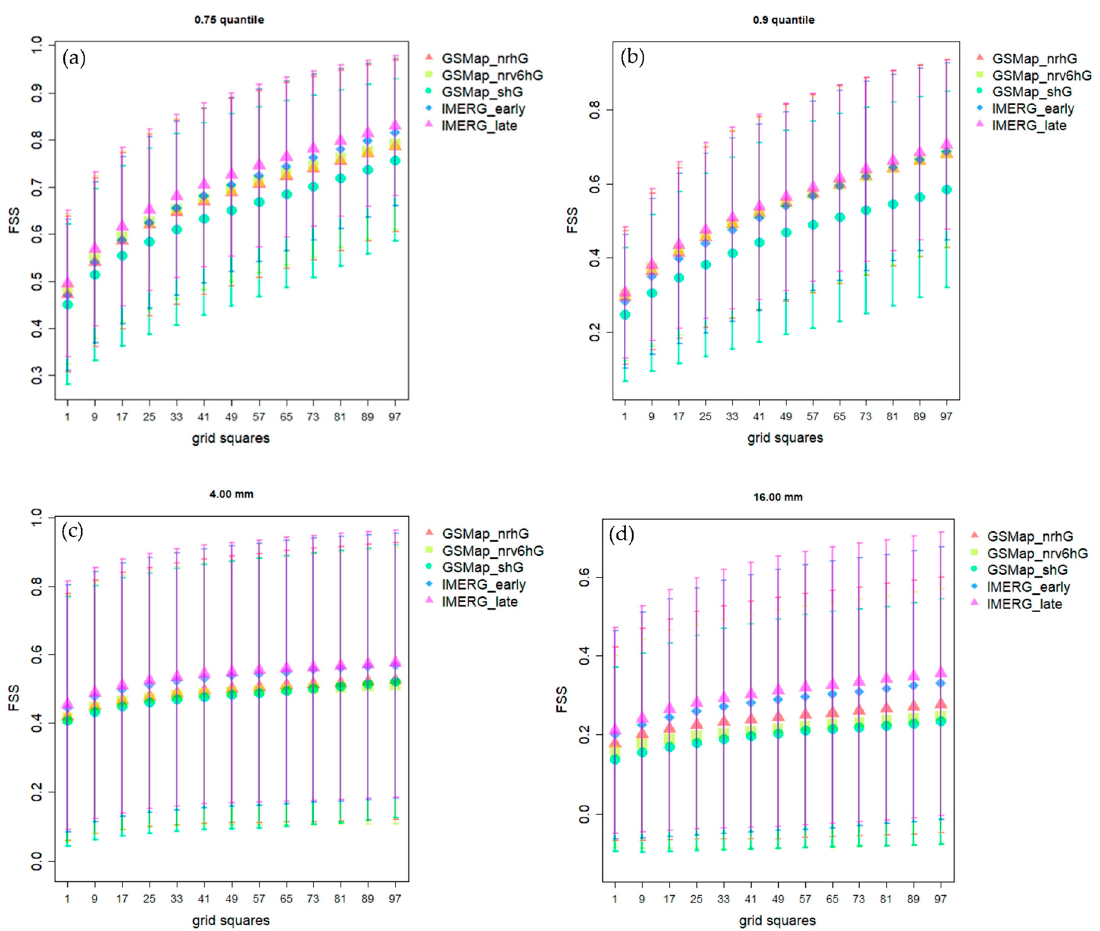
Figure 3. Spatial distribution of precipitation using fractions skill score (FSS). The datasets were analyzed over a square area of 200 km by 200 km centered on the location of the Namoi radar. Results are shown for two relative thresholds, the 0.75 quantile ( a ) and the 0.9 quantile ( b ), and for two fixed thresholds of 4 mm ( c ) and 16 mm ( d ).